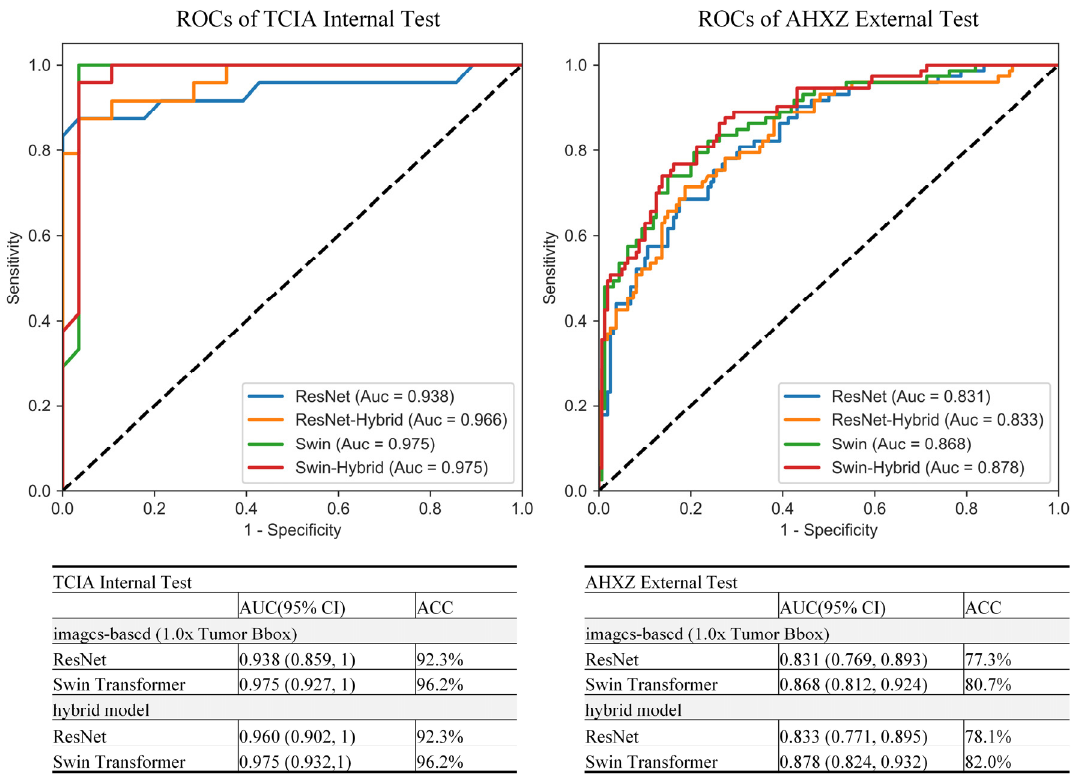
Figure 6. ROCs of the top performing image-based models and their corresponding hybrid models.